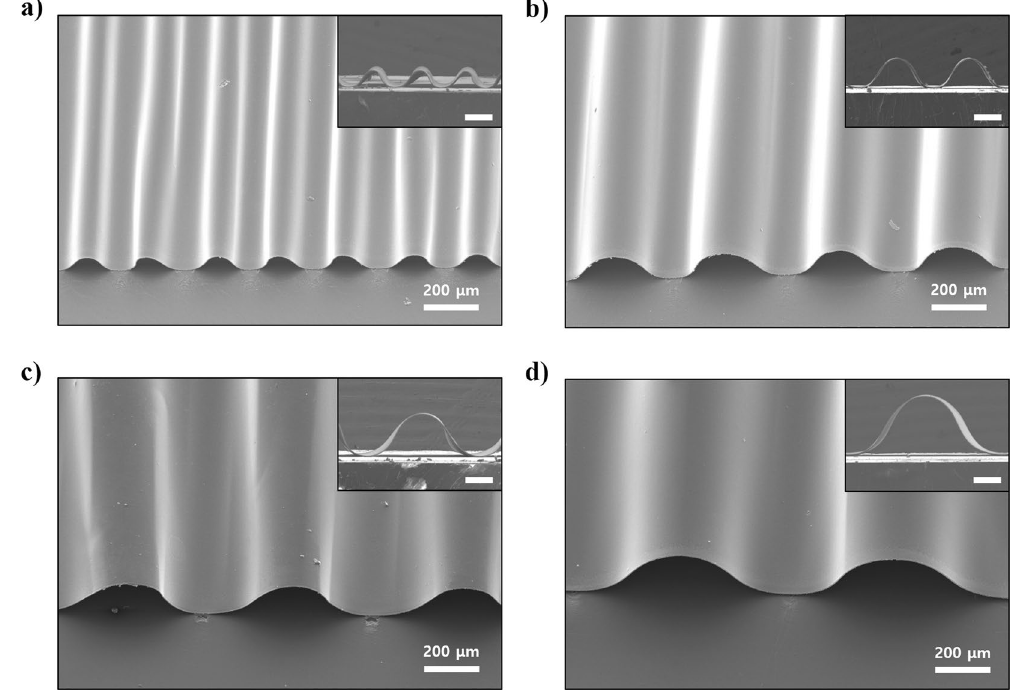
Figure 2. SEM images of the buckled aluminum electrode. Buckled aluminum electrode with chemical bonding intervals of ( a ) 200 μ m, ( b ) 400 μ m, ( c ) 600 μ m, and ( d ) 800 μ m. The insets show the cross-sectional SEM images of the buckled aluminum electrodes with 150 μ m of scale bar.